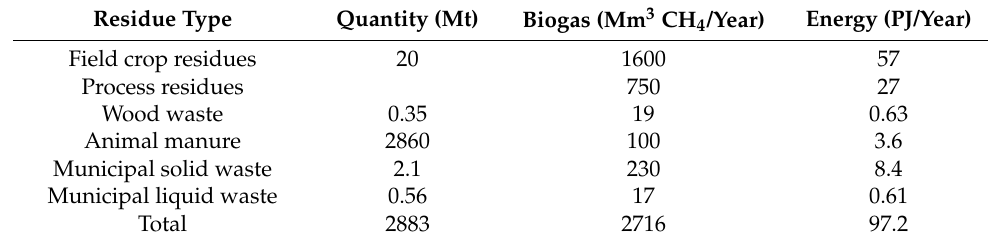
Table 1. Theoretical biogas potential from various organic waste sources in Ghana